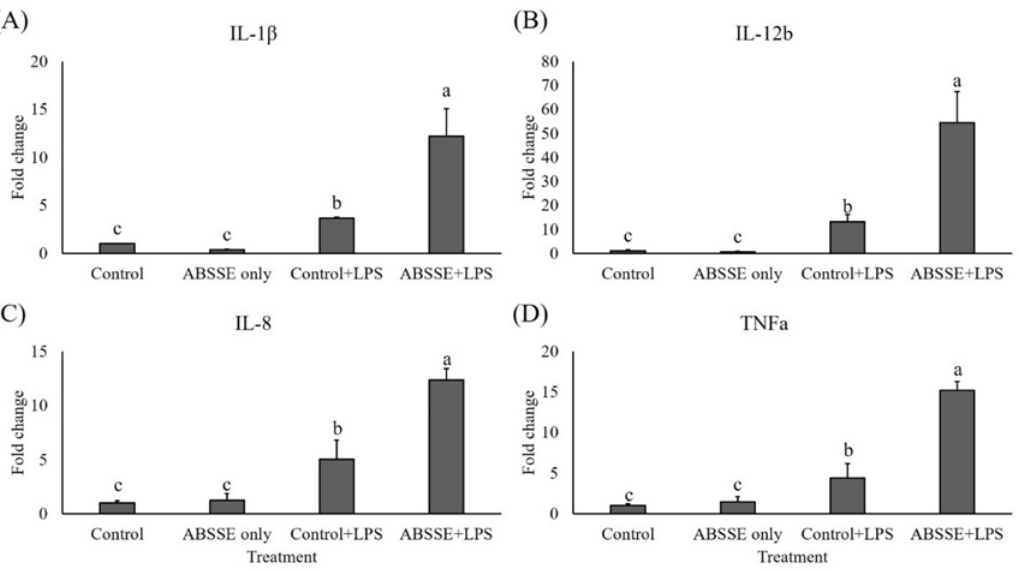
Figure 4. Gene expression analysis of Agaricus blazei spent substrate extract (ABSSE)-primed THK cells after stimulation with lipopolysaccharides (LPS). The THK cell line was primed with 0 (control) or 10 µ g/mL of Agaricus blazei spent substrate extract (group ABSSE only) for 24 h and subjected to gene expression analysis. Additionally, THK cells were pre-treated with L-15 medium or medium containing ABSSE and then stimulated with 50 µ g/mL LPS for 24 h. The former group was named “control + LPS” and the later “ABSSE + LPS”. Transcript levels of ( A ) IL-1 β , ( B ) IL-12b , ( C ) IL-8 , and ( D ) TNF- α were analyzed by quantitative real-time PCR. The expression values are shown as means + standard errors of the mean fold change relative to the control group. Significant differences ( p < 0.05, one-way ANOVA, and Tukey’s post hoc test) from the control group are indicated by different